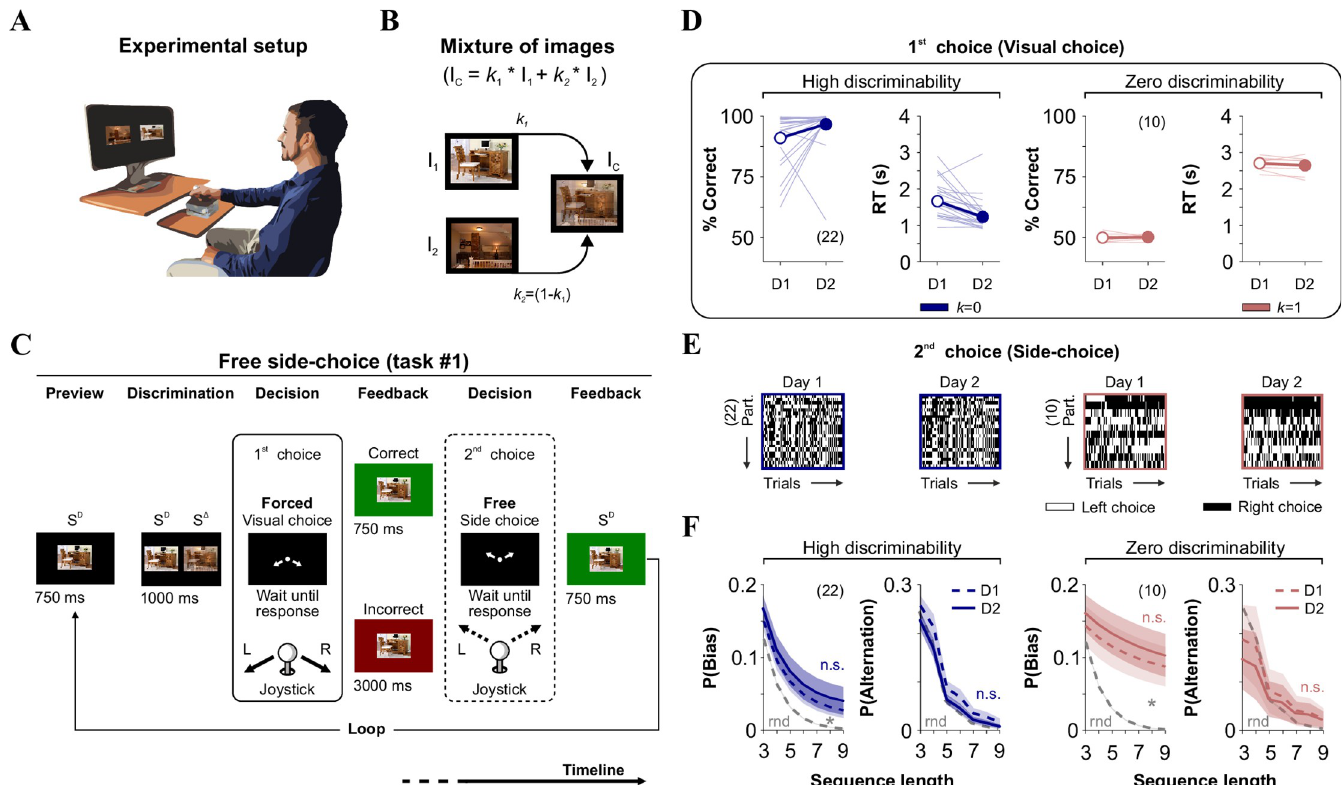
Fig 1. Stable side-biased and alternating probabilities in the free side-choice task. (A) Cartoon of the experimental setting where we measured perceptual and side- choices in humans. (B) The difficulty of discrimination is controlled by increasing image similarity (SIM, when k ! 1). (C) Stimulus timeline of the visual task. Each trial involves a discriminative (visual) forced-choice (1 st choice, where the side of the S D side predicts reduced delay interval), and a free side-choice (2 nd choice). We included auditory and visual feedback after recording joystick responses. (D) % Correct choices and response times (RT; in s) for two groups of participants tested with high ( k = 0) or zero ( k = 1) discriminability conditions. Thin lines: individual performances; thick lines and symbols: average ± S.E.M. (E) The side-choices from unsorted participants illustrated as colormaps with black (right) or white (left) rectangles across trials (x-axis). (F) Stable side and alternating choice probabilities across two experimental days. Number of subjects in